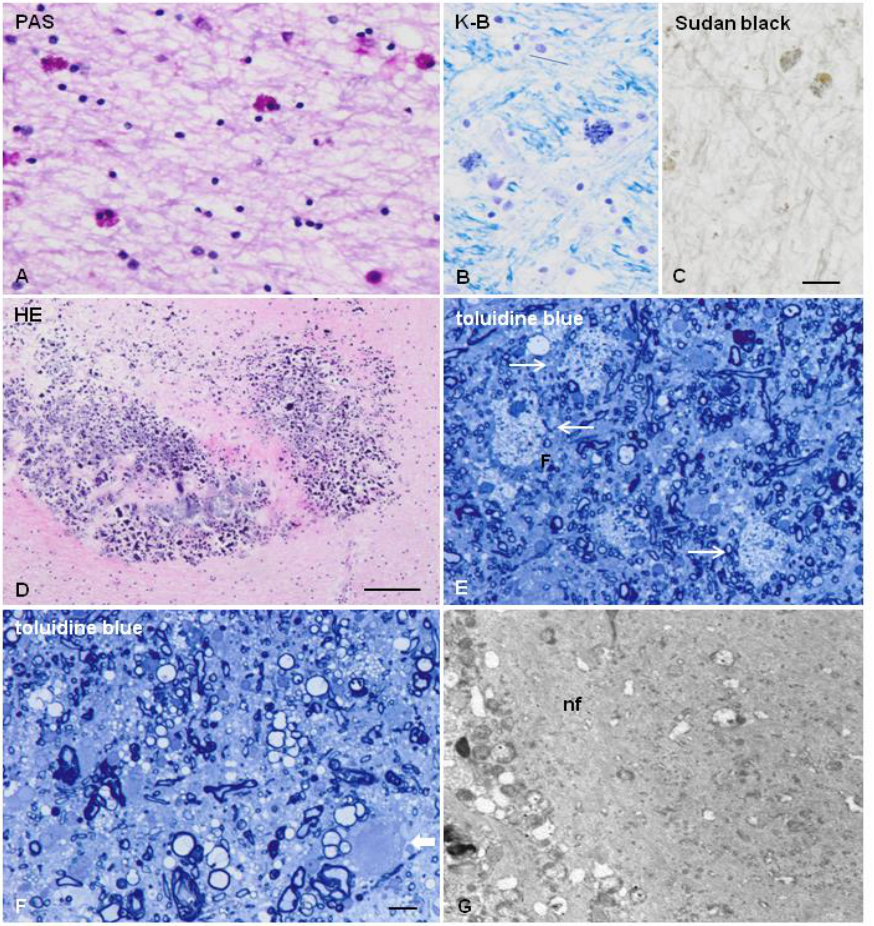
Figure 2. ALSP. ( A – C ) Glial cells filled with pigment as seen with periodic acid – Schiff (PAS) ( A ), Klüver – Barrera (K-B) ( B ), and Sudan black ( C ) staining in the frontal white matter. ( D ) Microcalcifications in the frontal white matter near the lateral ventricle. ( E , F ) Semi-thin sections stained with toluidine blue showing loss of myelin, macrophages filled with neutral lipids (thin arrows in ( E )), and axonal ballooning (thick arrow in ( F )). ( G ) Axonal ballooning filled with neurofilaments (nf) in the white matter. ( A – D ), formalin-fixed samples, paraffin sections; ( E – G ), samples fixed with glutaraldehyde, post-fixed with osmium tetraoxide, and embedded in araldite; ultra-thin sections stained with uranyl acetate and lead citrate. ( A – C ), bar = 25 μm; D = 100 μm; E - F = 10 μm.